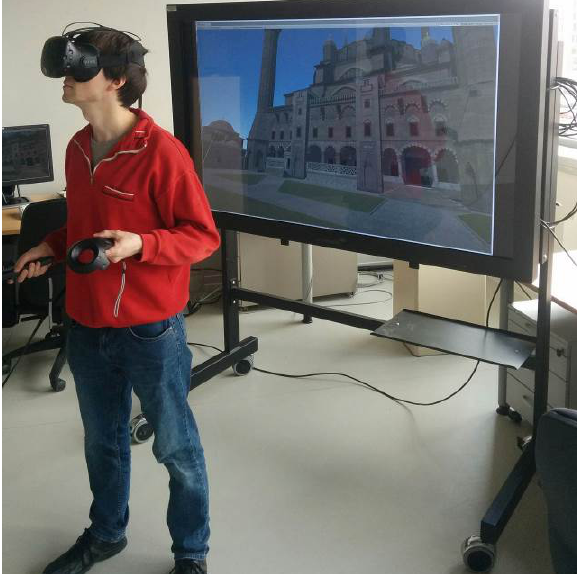
Fig. 9. The Virtual Reality System HTC Vive in action using